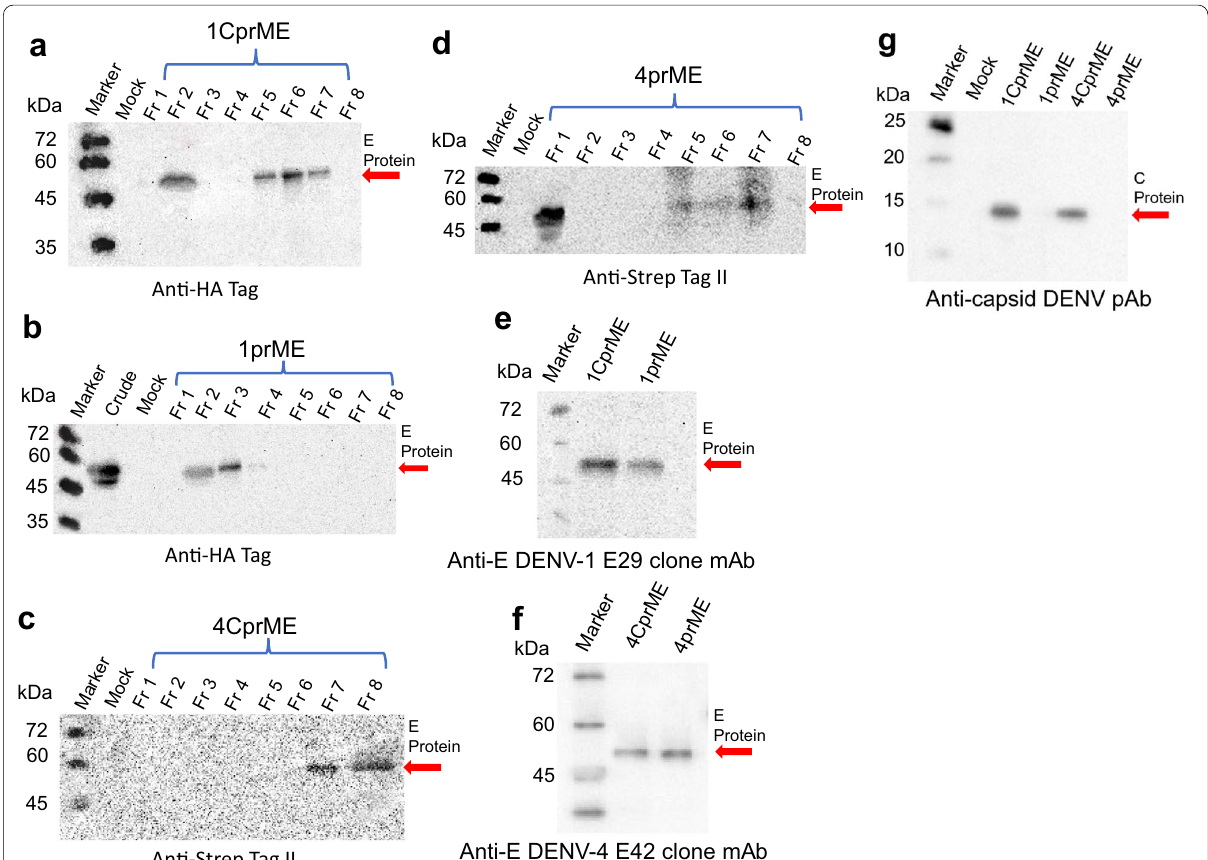
Fig. 2 Western blot of purified ( a ) 1CprME, ( b ) 1prME, ( c ) 4CprME and ( d ) 4prME protein fractions (Fr). Each protein was purified from silkworm hemolymph using anti-FLAG tag protein purification gel column chromatography. E protein was verified using specific serotype monoclonal antibodies using ( e ) an anti-E E29 clone for DENV-1 constructs and ( f ) an anti-E E42 clone for DENV-4 antibodies. The C protein also confirmed using anti-capsid pAb ( g